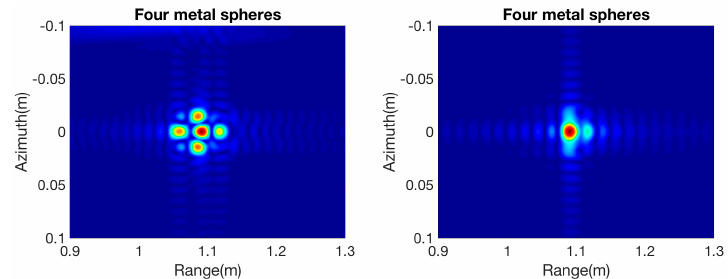
Figure 16. Images of a cluster of two by two metal spheres in backward and forward modes ( left : monostatic; right : bistatic).